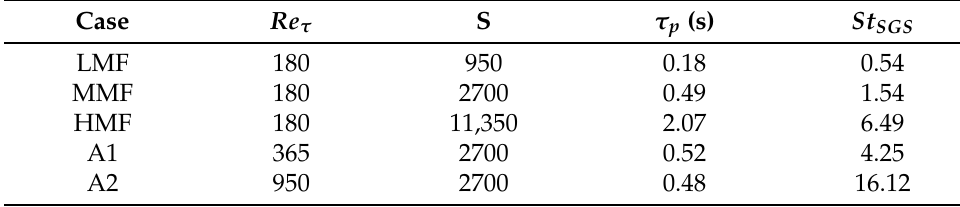
Table 10. Values of St SGS for each simulation. S and τ p values included for